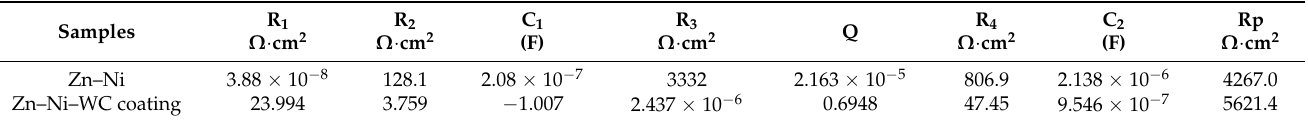
Table 3. Electrochemical kinetic parameters of the coatings extrapolated from EIS.